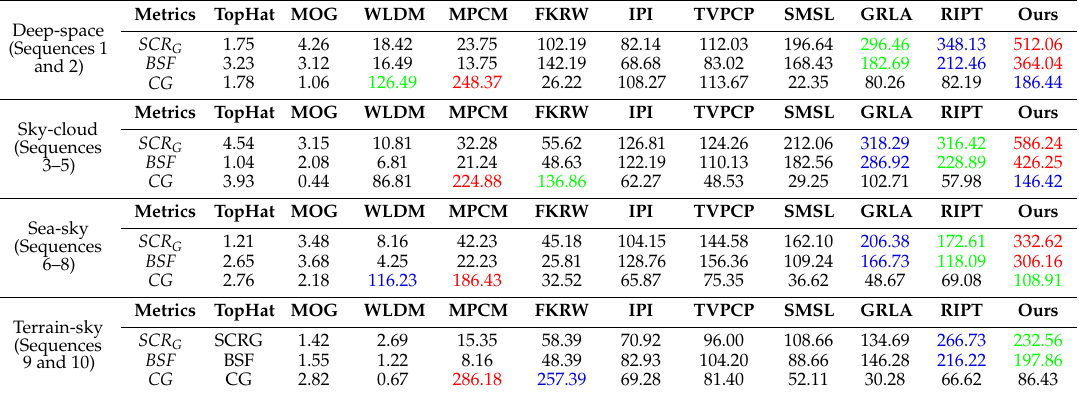
Table 5. Comparison of the baselines with our method for average SCR G , BSF , and CG for di ff erent scenarios. The red means the best, blue means the second and green means the third. Deep-space (Sequences 1 and